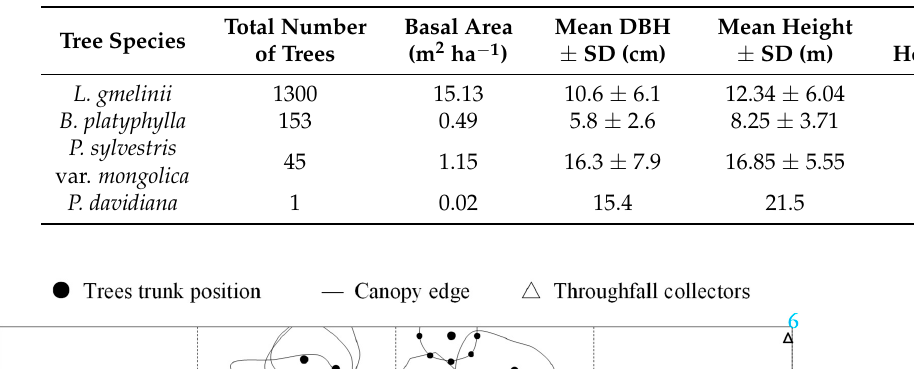
(Table 1). The experimental plot (20 × 20 m) is adjacent to the permanent plot and has similar flora. In the experimental plot, the leaf area index (LAI) is 1.64 ± 0.68, and the under- plot are shown in Figure 1. Table 1. Forest conditions in the permanent plot.